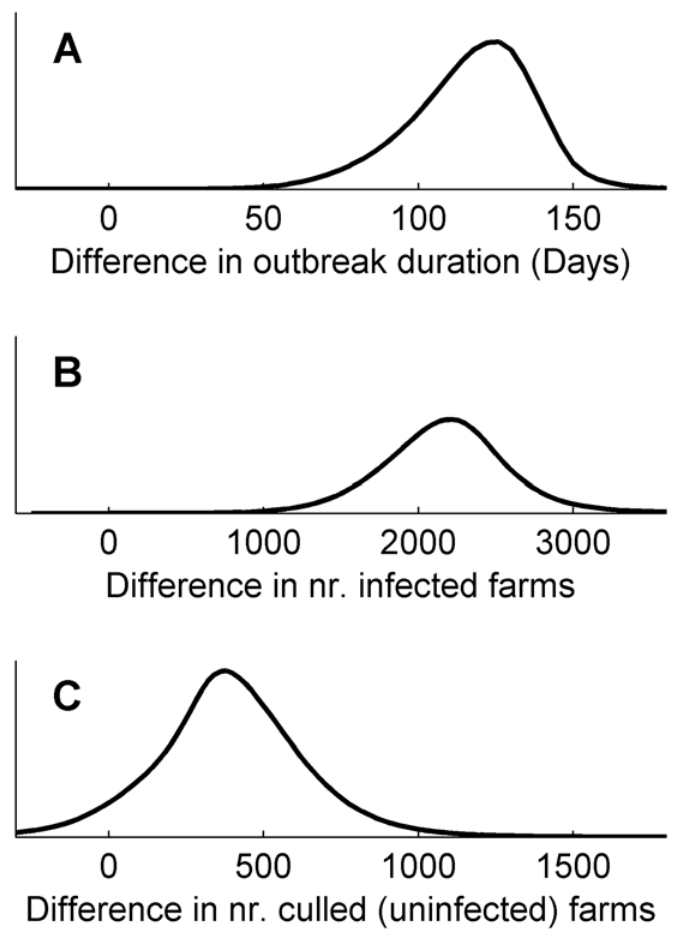
Fig 7. Posterior estimates of difference between controls. The figure shows the marginal posterior predictive estimates of difference in outbreak duration (Panel A), number of infected farms (Panel B) and number of control culls (Panel C) between the implemented and alternative control action. The figure shows the result of the large discrepancy